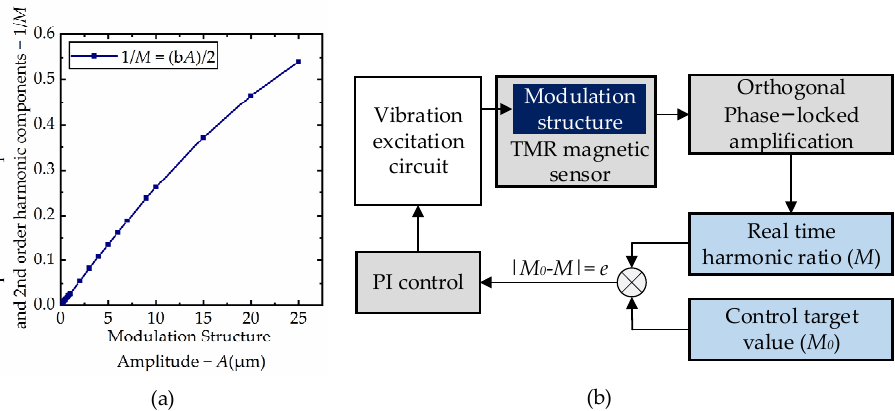
Figure 4. Modulated signal harmonic component and amplitude control method: ( a ) numerical simulation results of the relationship between the ratio of harmonic components and amplitude; ( b ) control schematic diagram.